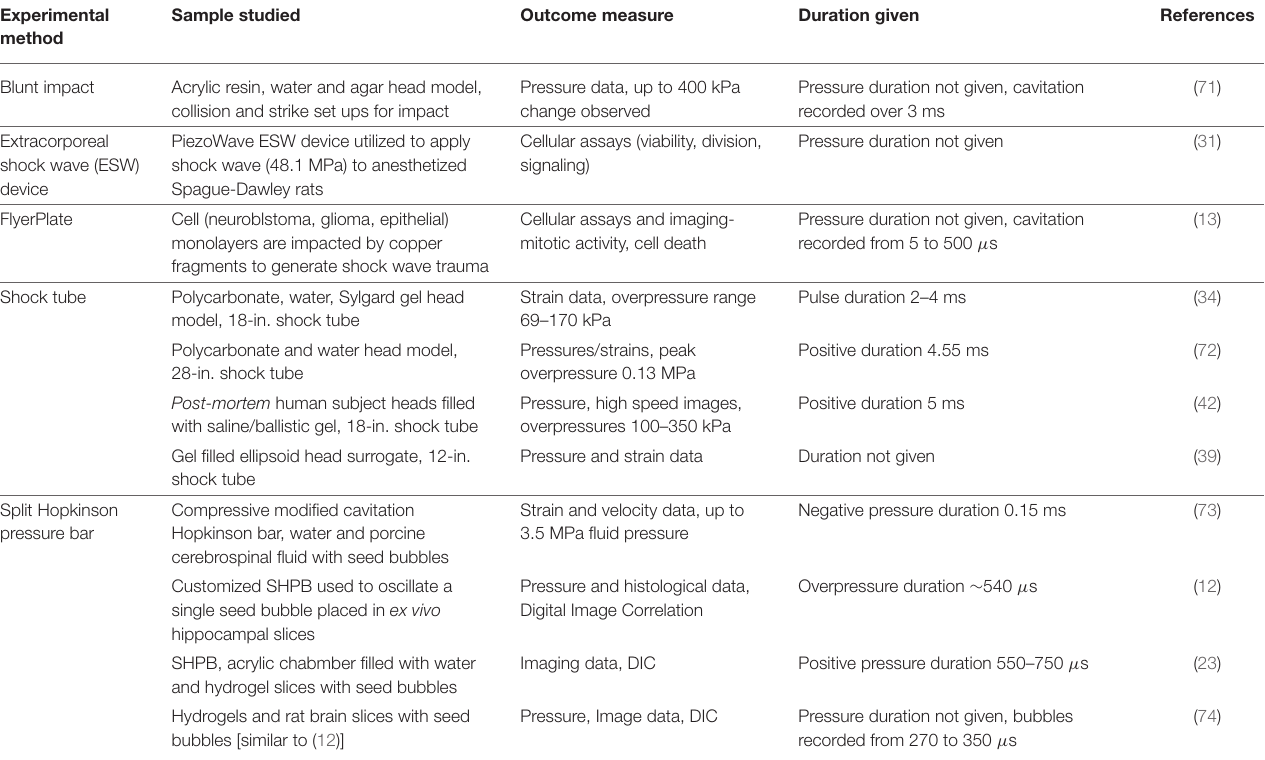
TABLE 1 | A summary of experimental studies conducted on brain injury using